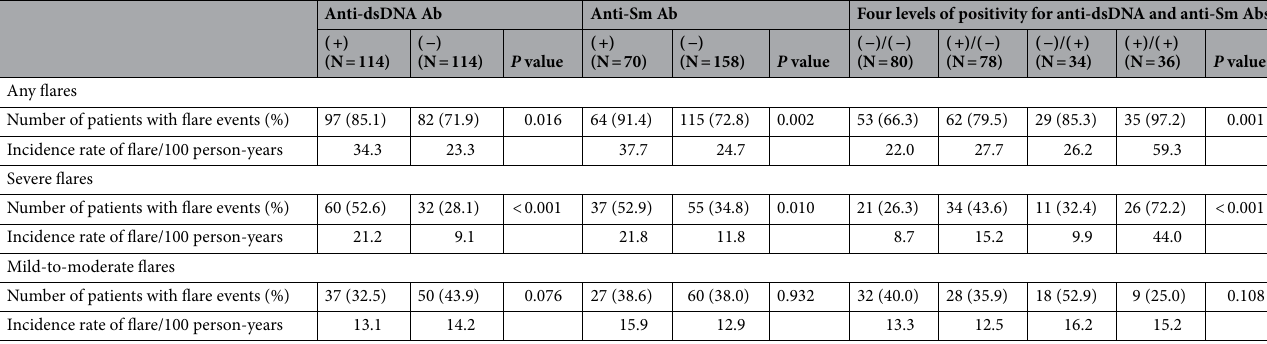
Table 5. Flare events according to positivity of anti-dsDNA Ab and anti-Sm Ab. ds double-stranded; Ab